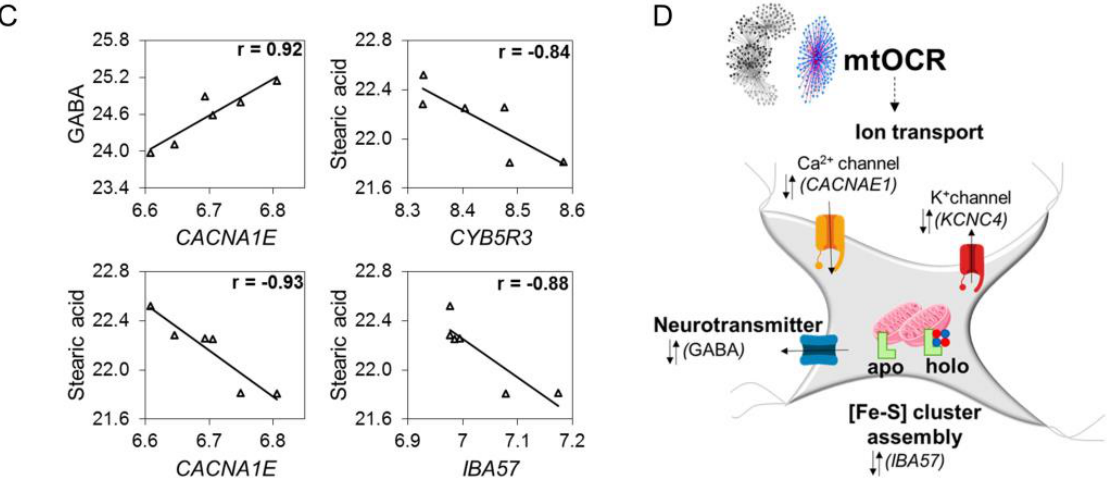
Figure 5. Community 3: oxidative phosphorylation subnetwork associated with signaling markers for ion transport, neurotransmitter metabolism and iron sulfur cluster assembly. Pathway enrich- ment analysis of genes and metabolites associated with basal OCR and proton leak dependent OCR (mtOCR) subnetwork were studied. ( A ) Top pathways enriched by mtOCR-dependent genes at p < 0.05, represented as −log 10 P. Expression of individual genes associated with biphasic mtOCR from